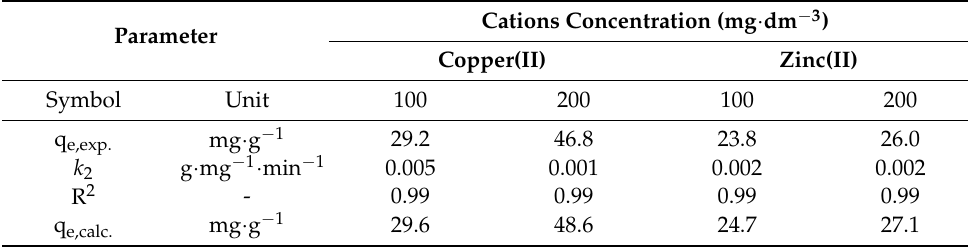
Table 5. Pseudo-second-order kinetic parameters obtained by linear method at different copper(II) and zinc(II) cations